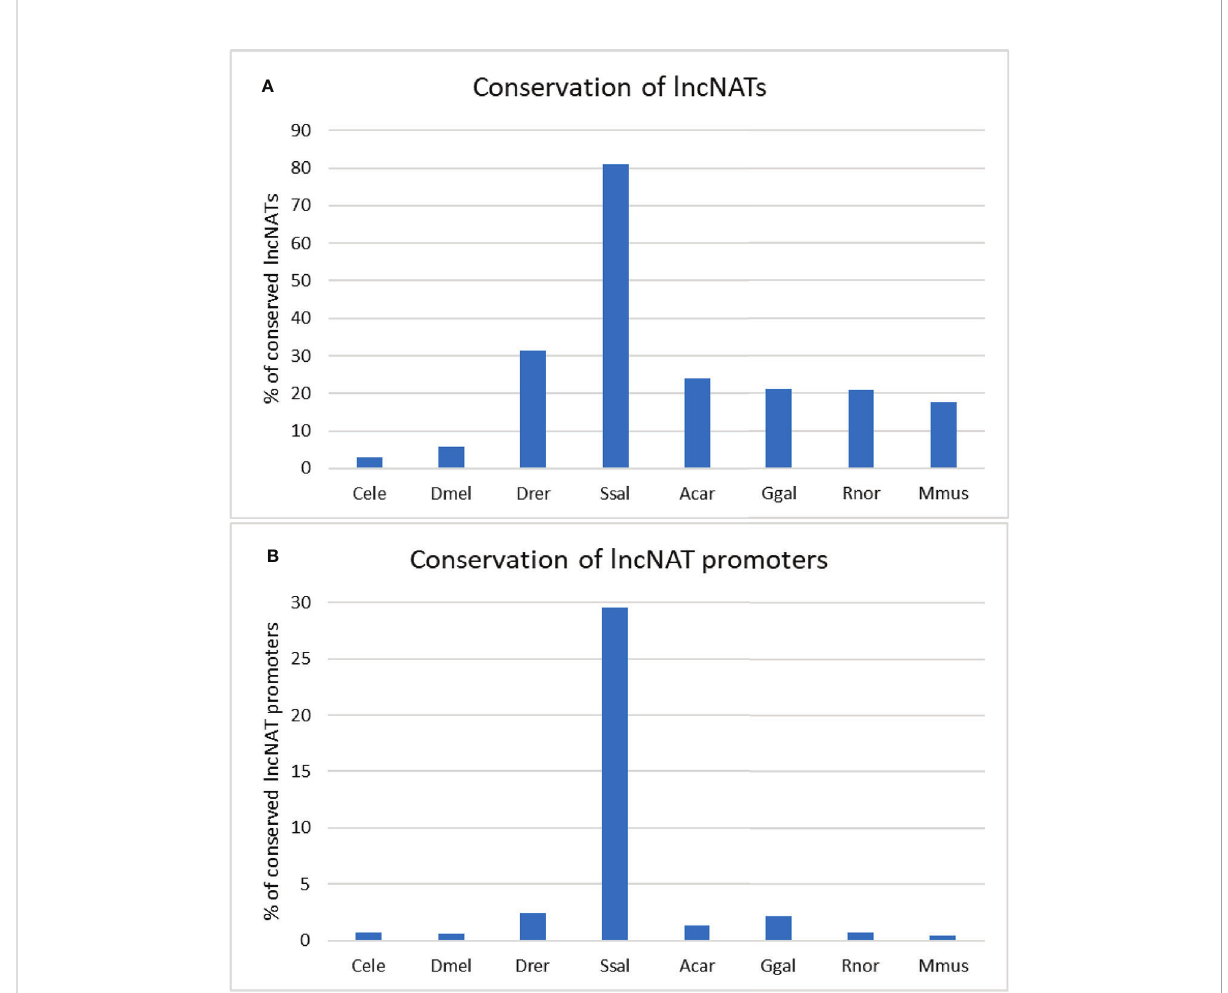
FIGURE 3 Percentage of conserved rainbow trout ’ s lncNATs and their promoters across closely- and distantly-related species. Trout ’ s lncNATs (A) and their promoters (B) are more conserved in Atlantic salmon and zebra fi sh. Each species is represented on the X-axis by the fi rst letter of the genus name and the fi rst three letters of the species name; ( Caenorhabditis elegans “ Cele ” , Drosophila melanogaster “ Dmel ” , Danio rerio “ Drer ” , Salmo salar “ Ssal ” , Anolis carolinensis “ Acar ” , Gallus gallus “ Ggal ” , Rattus norvegicus “ Rnor ” , and Mus musculus “ Mmus ”